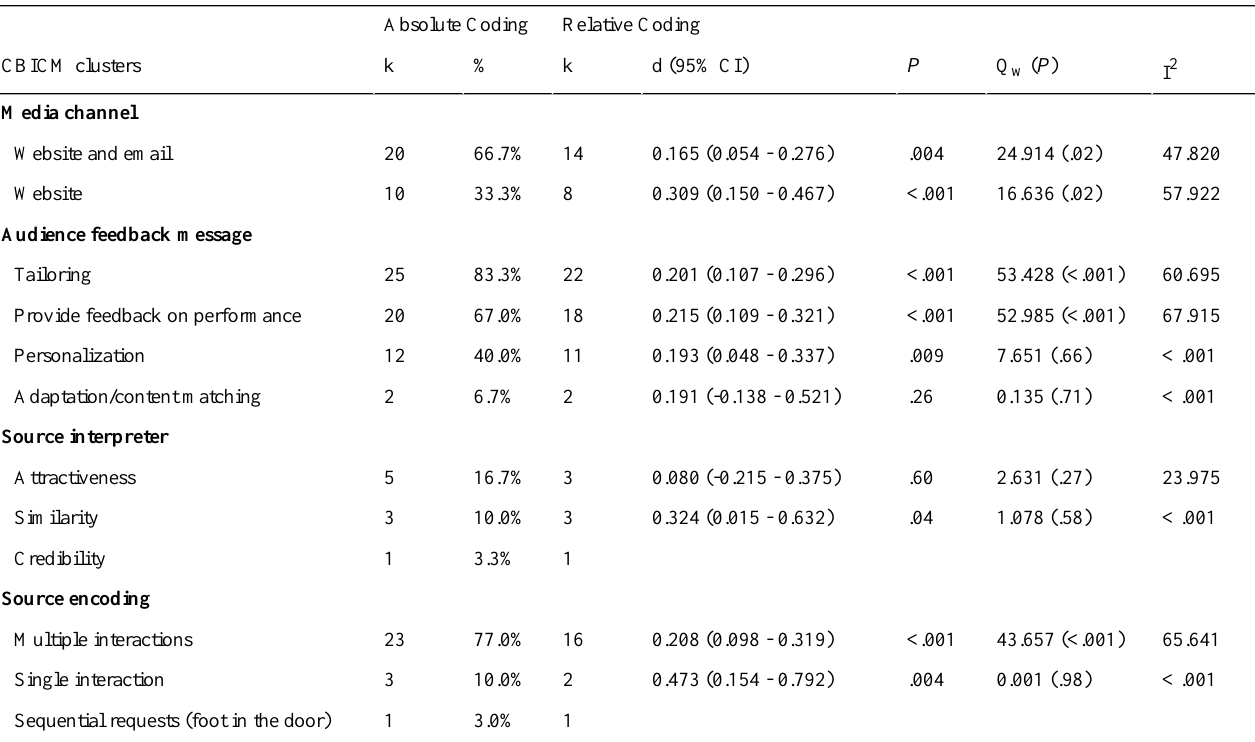
Table 5. Media channel, feedback message, source interpreter, and source